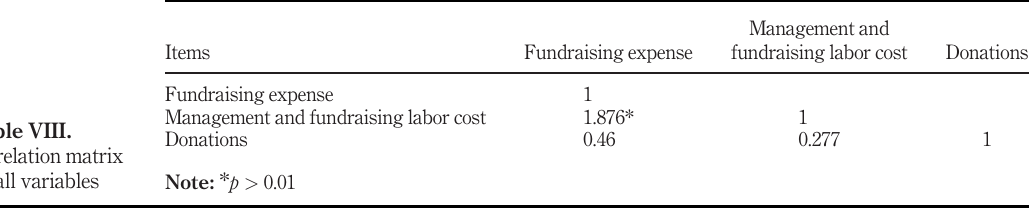
Table VIII. Correlation matrix for all variables